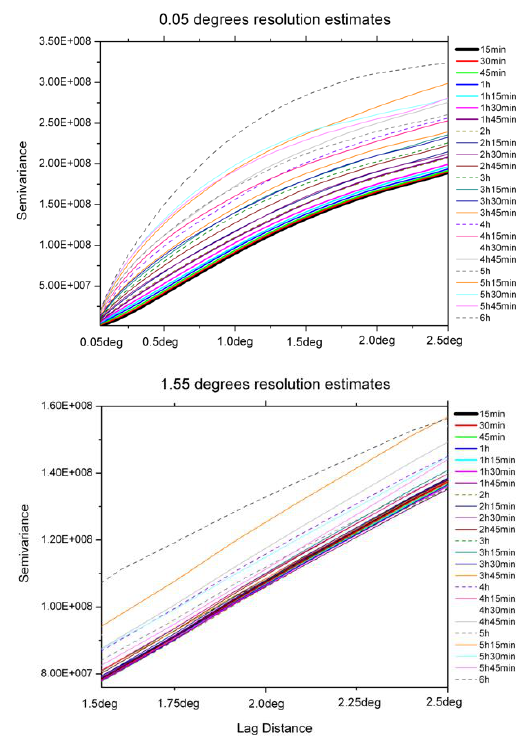
Figure 6. Semivariograms for 0.05 ◦ and 1.55 ◦ spatial resolution simulations, covering all the temporal samplings.